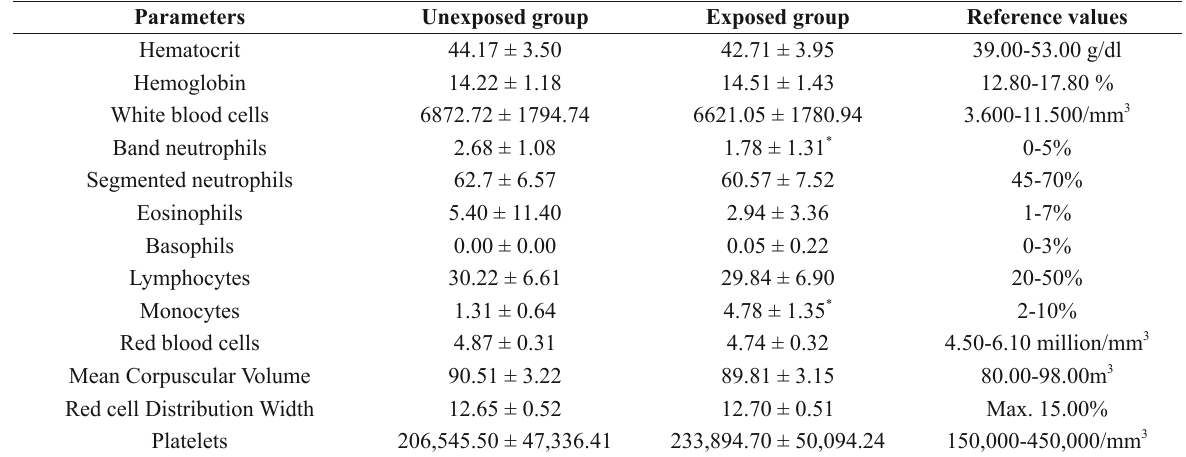
* Signi fi cant difference as compared to the control group (unexposed) at P < 0.05 ( Student t- test).